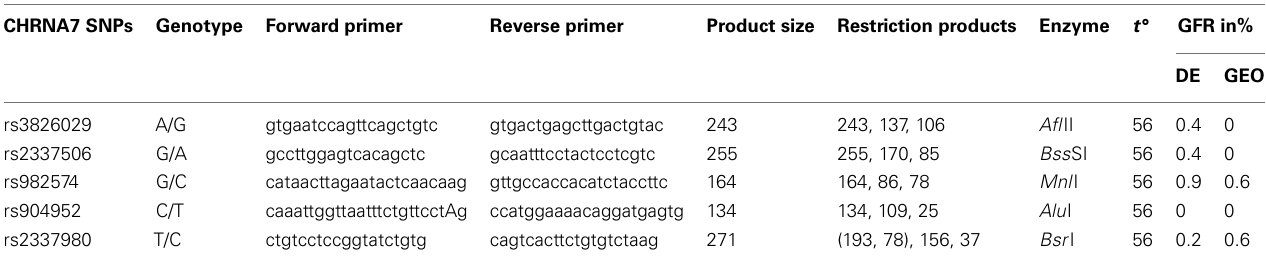
Table 3 |Amplification and restriction details of SNPs studied.